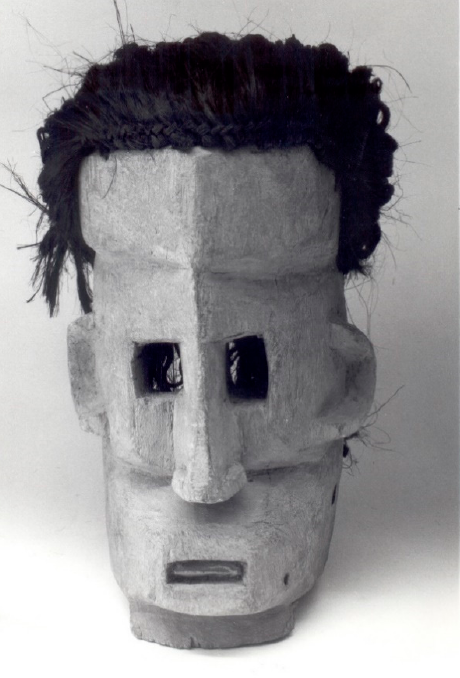
Figure 5. This is, thus, more or less the author.